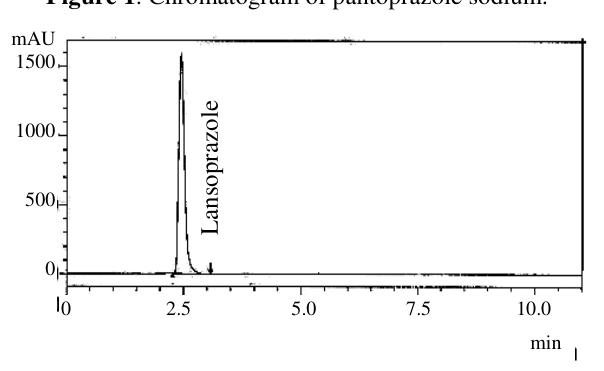
Figure 2 . Chromatogram of